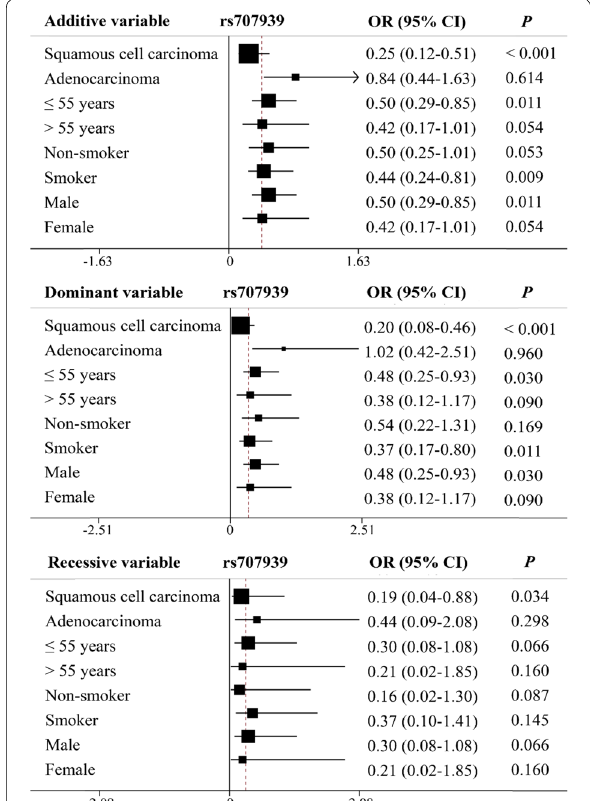
Fig. 1 Stratification analyses of the associations between the MutS homolog 5 ( MSH5 ) rs707939 polymorphism and overall platinum‑ based chemotherapy toxicity in the 220 non‑small cell lung cancer patients using the additive, dominant, and recessive models. Each box and horizontal line represents an odds ratio (OR) and a 95% confidence interval